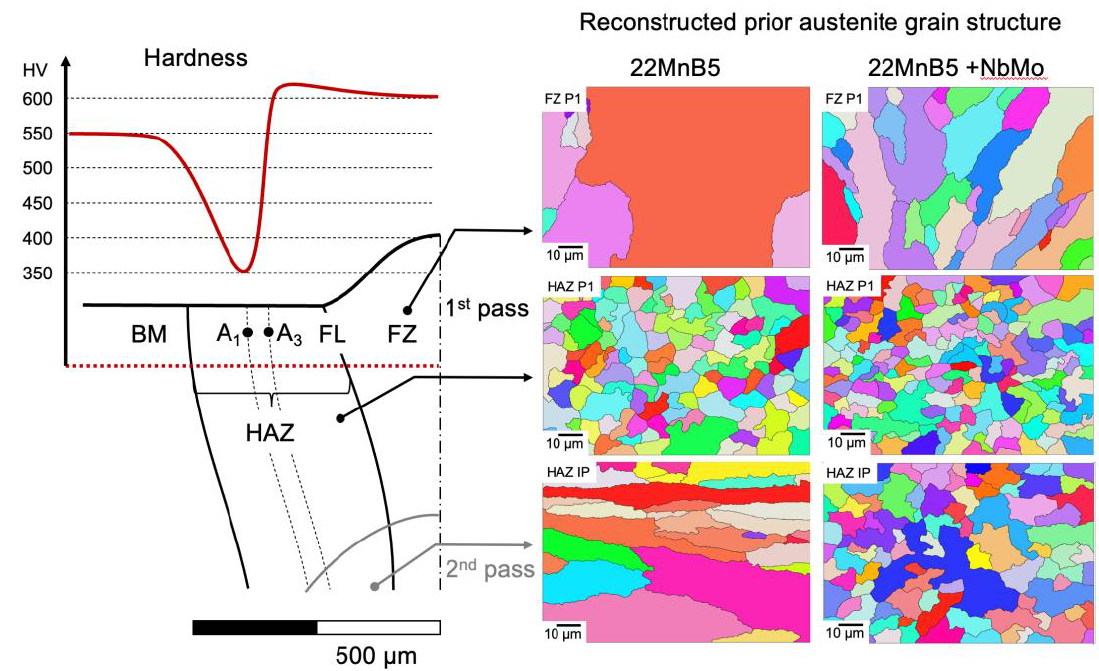
Figure 7. Microstructural characteristics in the heat-affected zone (HAZ) and fusion zone (FZ); A 1 and A 3 are the transformation temperatures delineating the intercritical zone (dashed lines); IP designates the interpass zone experiencing two successive weld passes; BM is the base material. Micro Vickers hardness evolution across the weld zone (dotted red line) is similar in both steels.